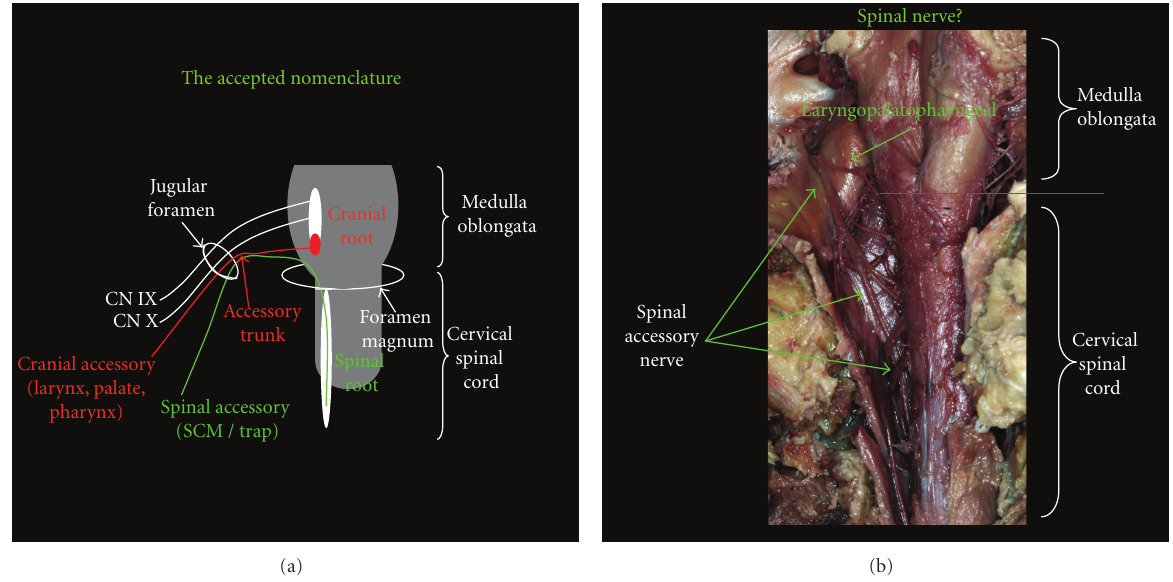
Figure 1: Cranial root of accessory exits from the caudal region of the nucleus ambiguus. The spinal root of the accessory originates within cervical spinal cord and ascends through the foramen magnum. Cranial nerves IX (not pictured), X, and both roots of the accessory exit the jugular foramen. Cranial accessory joins vagus at or beyond the jugular foramen prior to innervating musculature of the palate, pharynx, and larynx. The cranial root of the accessory nerve can be seen passing in close proximity to the spinal accessory and vagus nerves. Purely empirical observations could easily lead to misinterpretation of the cranial root of the accessory nerve. View of cadaver dissection demonstrating the extent of the spinal accessory nerve located within the cervical region of the spinal cord. Also highlighted is the laryngopalatopharngeal (currently cranial accessory)